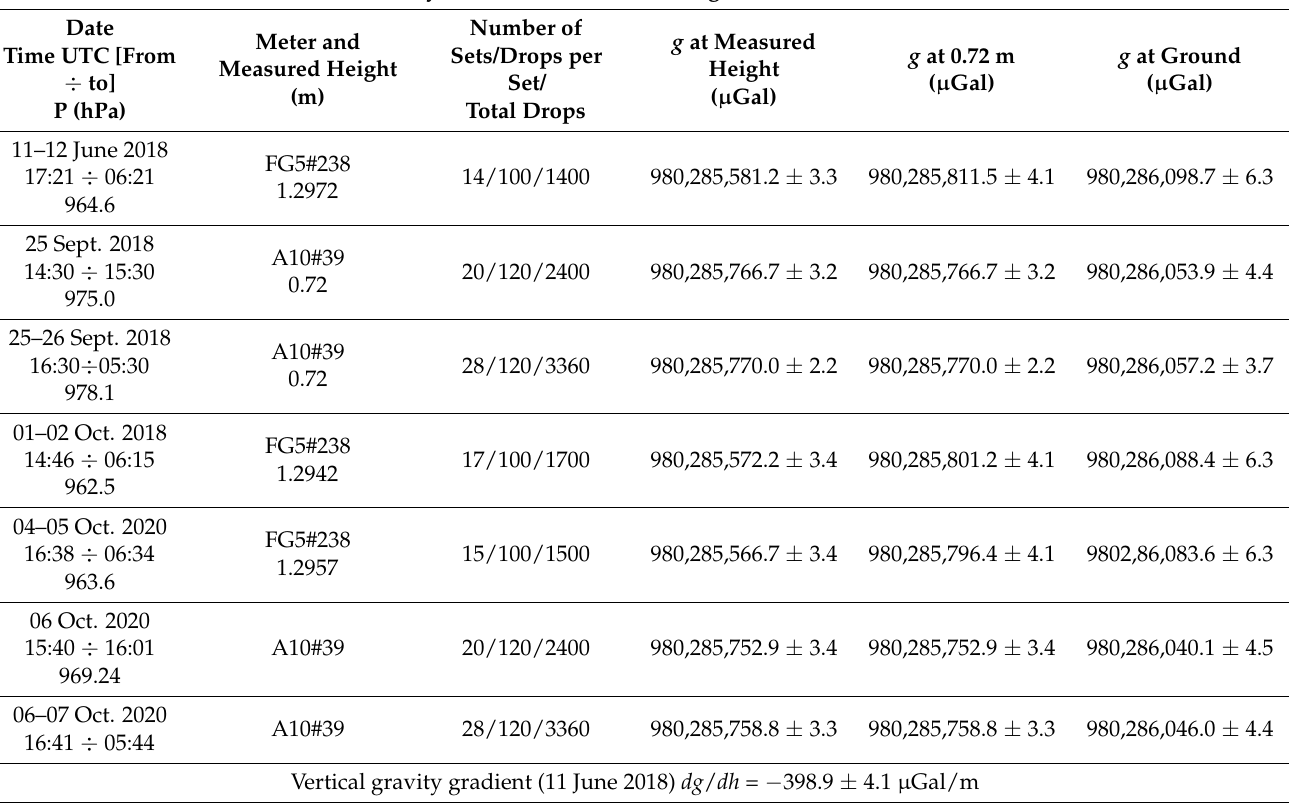
Table 4. Absolute gravity measurements collected at the Sant’Angelo Romano station (SARO) during June 2018–October 2018 and October 2020 period by FG5#238 and A10#39 absolute ballistic gravimeters. The combined uncertainties δ tot associated to the g values are also reported. Absolute Gravity Measurements at Sant’Angelo Romano Station